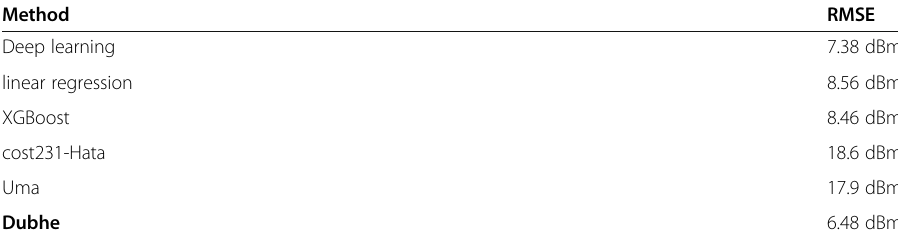
Table 8 Comparison of various methods Method